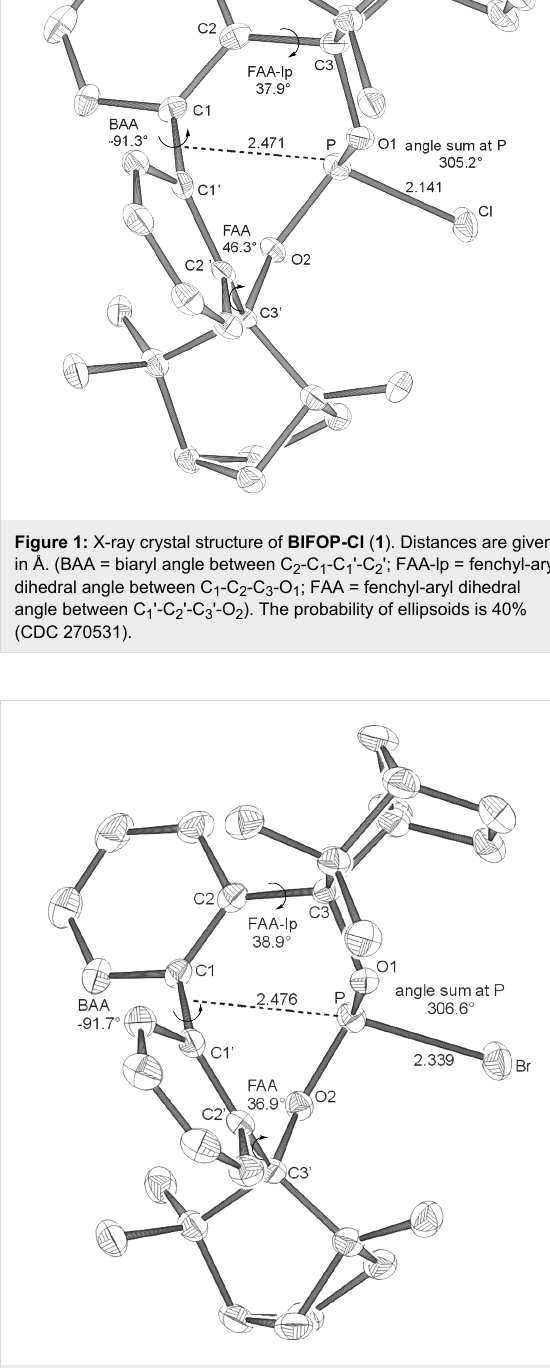
Figure 2: X-ray structures of BIFOP-Br ( 2 ). Distances are given in Å. (BAA = biaryl angle between C 2 -C 1 -C 1 '-C 2 '; FAA-lp = fenchyl-aryl dihedral angle between C 1 -C 2 -C 3 -O 1 ; FAA = fenchyl-aryl dihedral angle between C 1 '-C 2 '-C 3 '-O 2 ). The probability of ellipsoids is 30% (CCDC